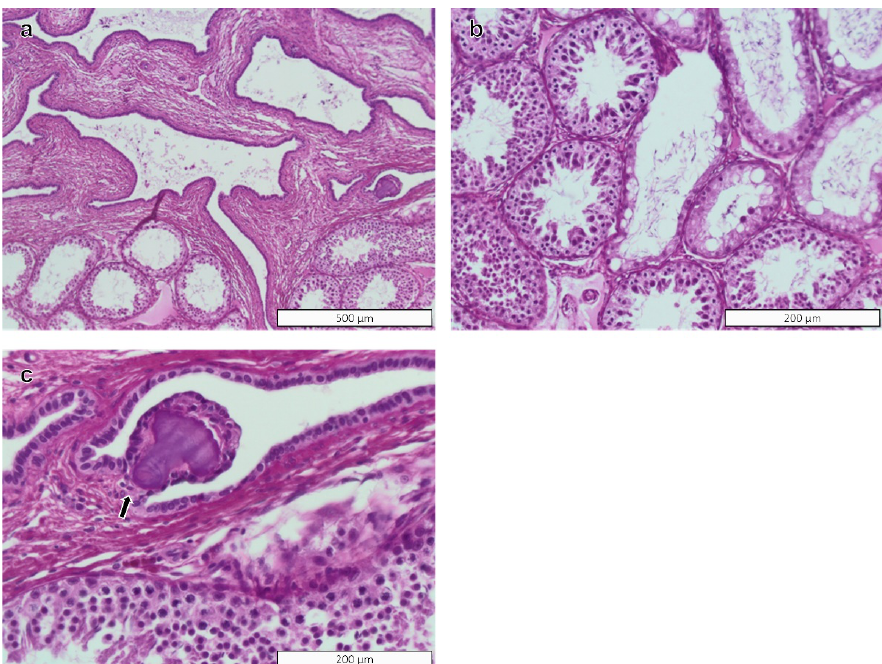
Figure 3. Rete testis of rams. Changes in rete testis of rams. ( a , b ) Rete testis and tubules near rete